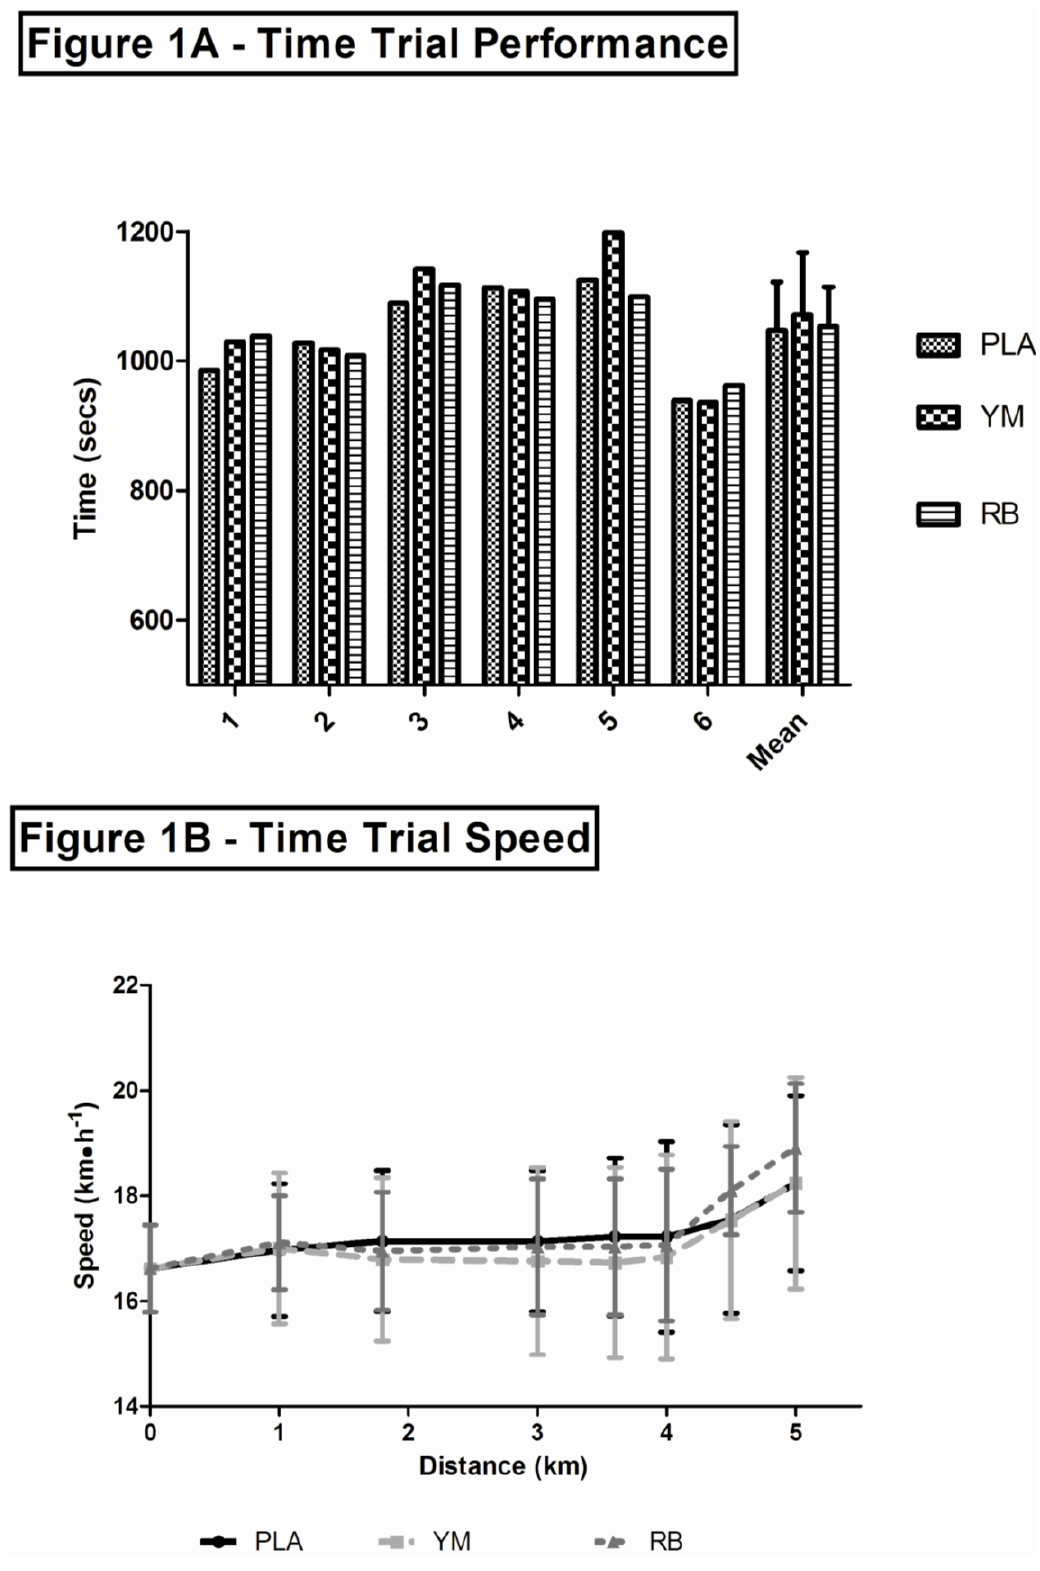
Figure 1. ( A ) Individual five kilometer performance and overall mean ± SD in response to ingestion of RB, YM, or PLA. ( B ) Mean ± SD running speed in response to ingestion of RB, YM, or PLA during TT. PLA = solid black line with squares (■); YM = dotted light grey line with triangles (▲); RB = dashed dark grey line with circles